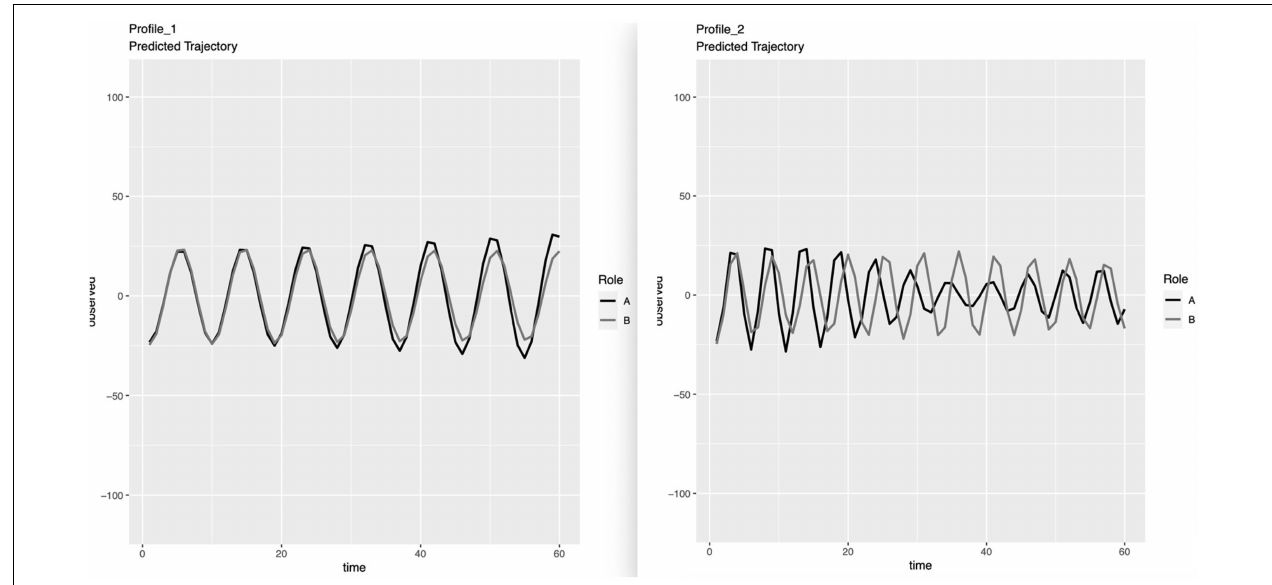
FIGURE 1 | Estimated IBI trajectories for the two profiles. The first profile characterized 109 topic-couple combinations, while the second characterized 24. For indistinguishable dyads, the distinguishing variable A/B was randomly assigned and should not be interpreted. Predicted trajectories for Profile 1: The Simple Profile. Predicted trajectories for Profile 2: The Complex Profile.